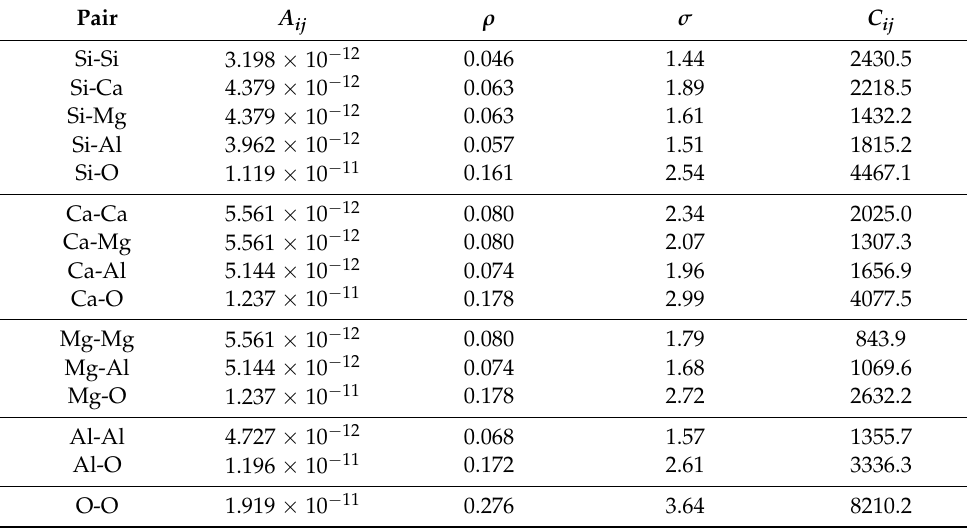
Table 1. Specific parameters for Born-Mayer-Huggins (BMH) potential [29].